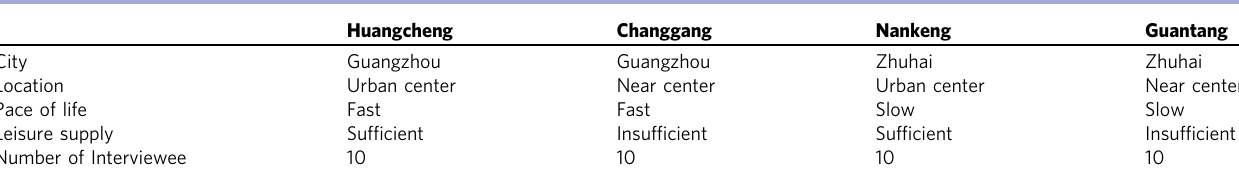
Table 3 Pro fi les of